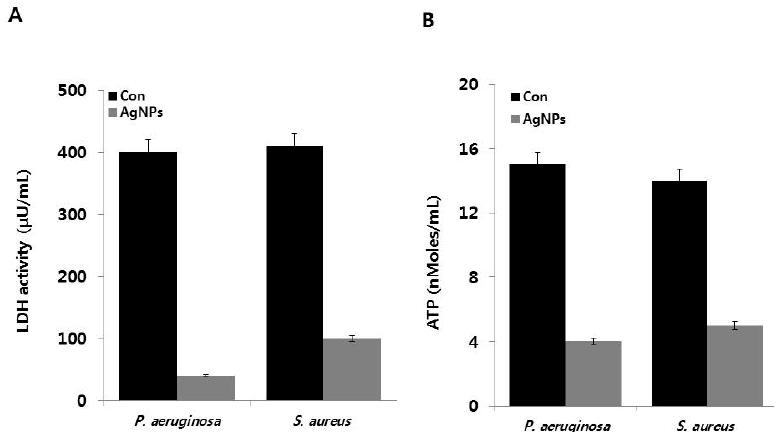
Figure 3. Effects of AgNPs on metabolic activity: ( A ) P. aeruginosa and S. aureus cells were incubated with respective MIC of AgNPs for 12 h. LDH activity was determined by measuring the reduction of NAD + to NADH and H + during the oxidation of lactate to pyruvate; ( B ) ATP levels were determined by measuring luminescence levels and comparing against an ATP standard curve. Results